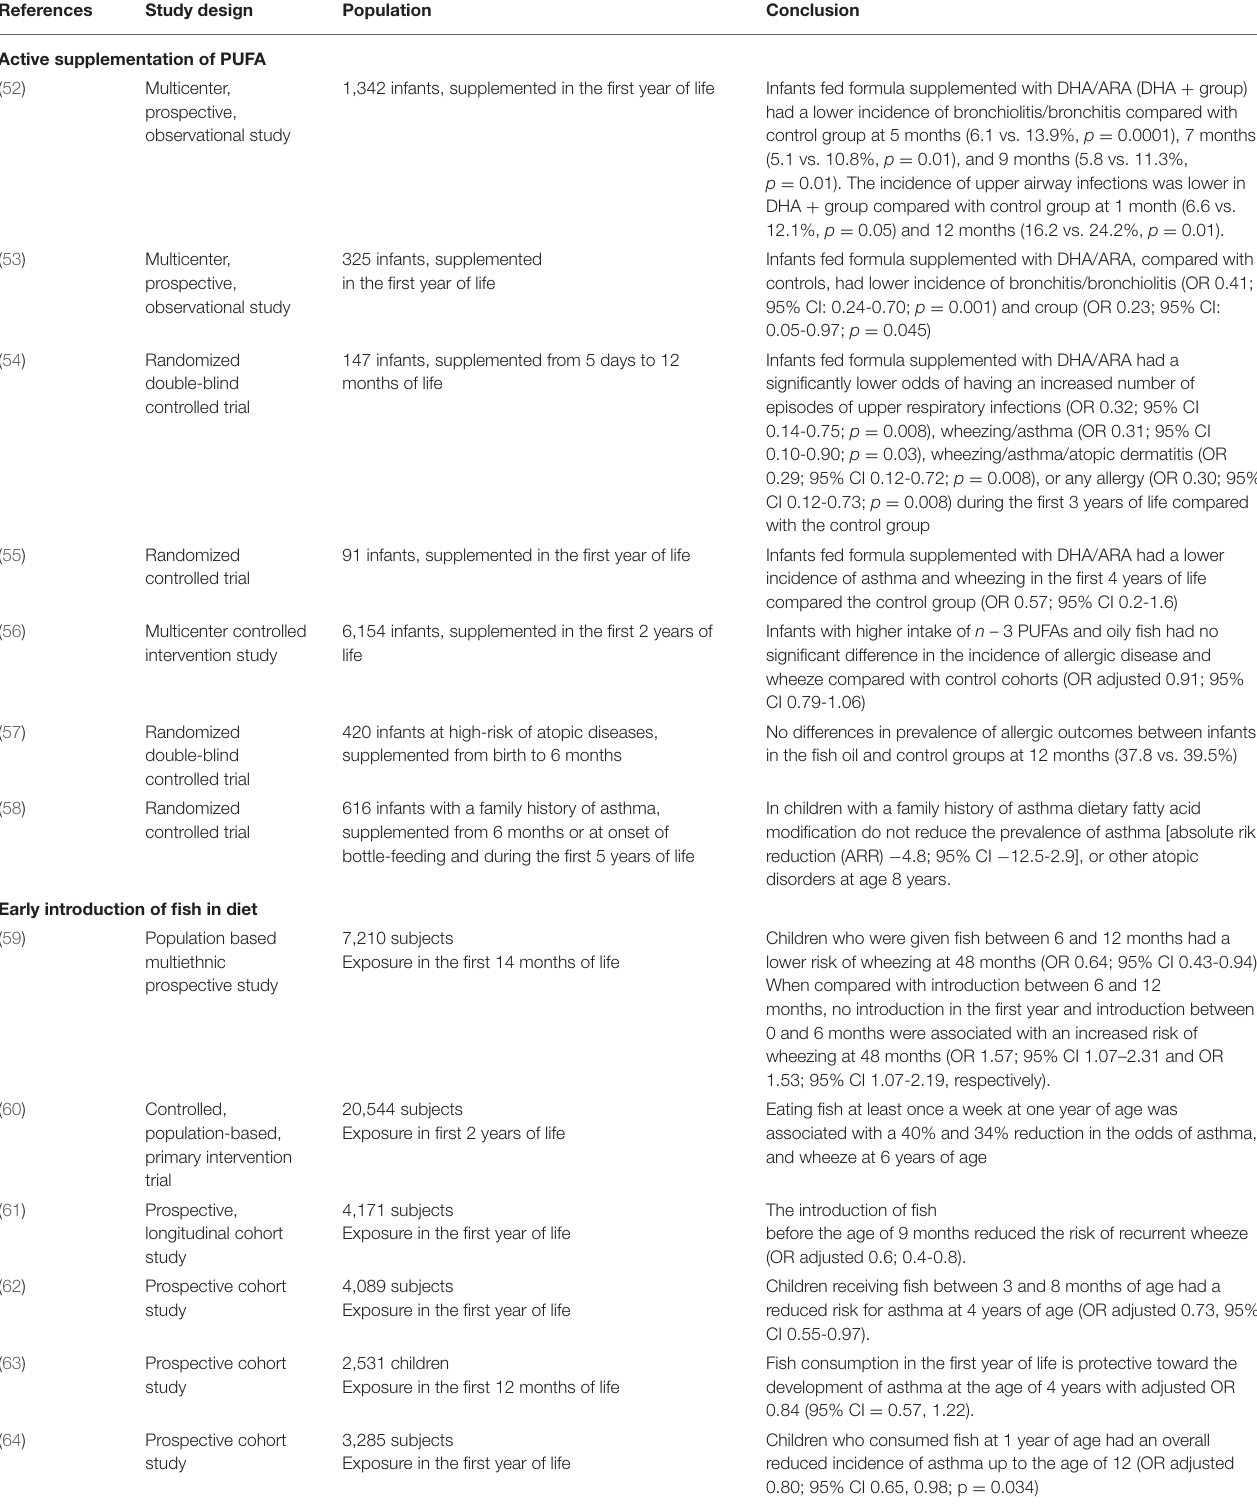
TABLE 3 | Main features and results of studies investigating active supplementation of PUFA and early introduction of fish in